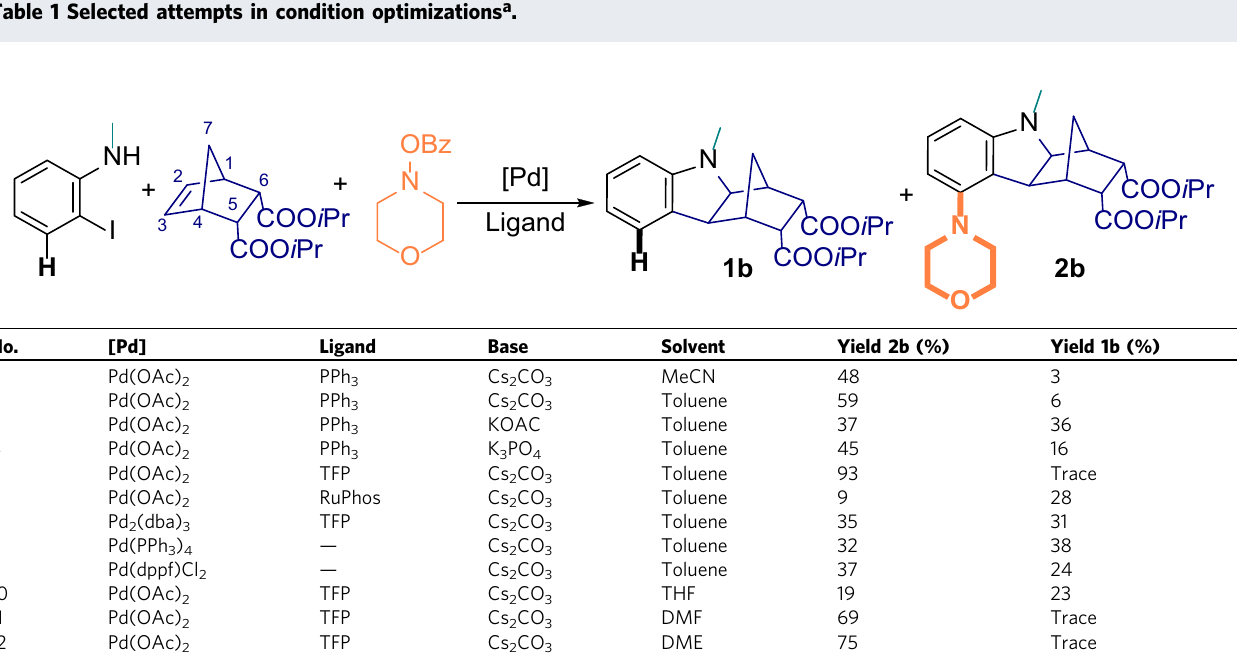
Table 1 Selected attempts in condition optimizations a .